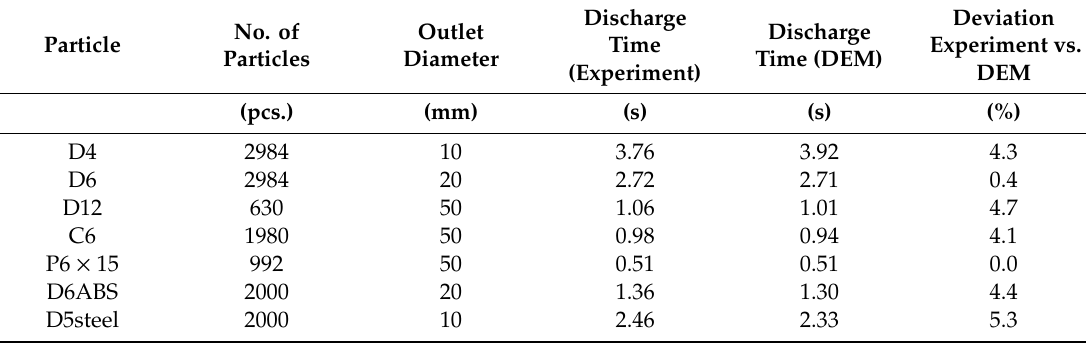
Figure 10. Discharge calibration tests. Table 16. Experimental and calibrated AoR values evaluated via geometrical